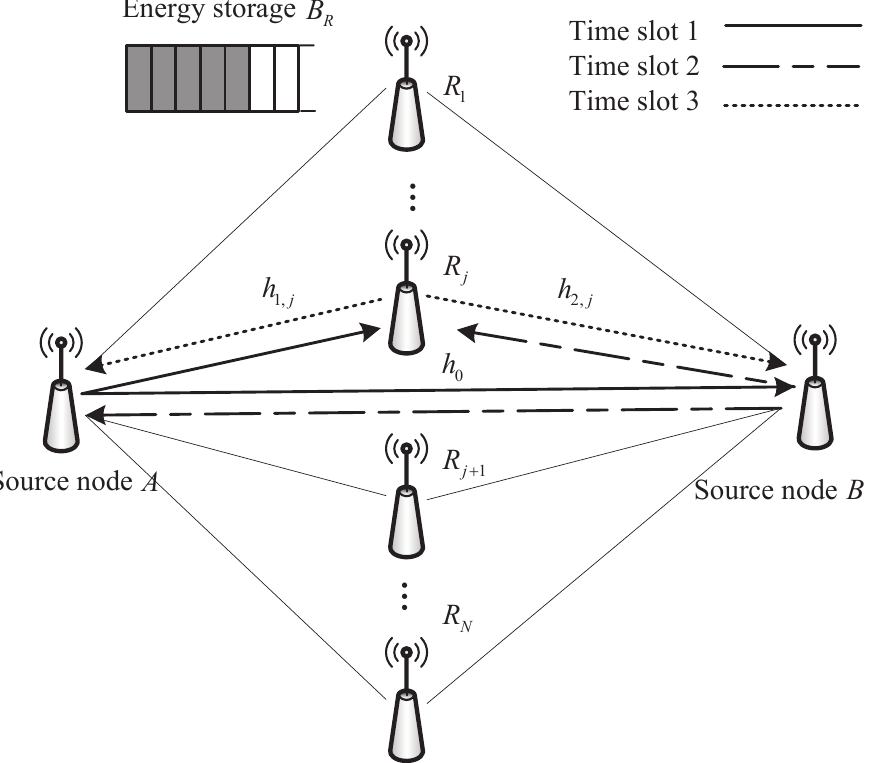
Figure 3. Model of two-way multi-relay communication system under the TDBC transmission